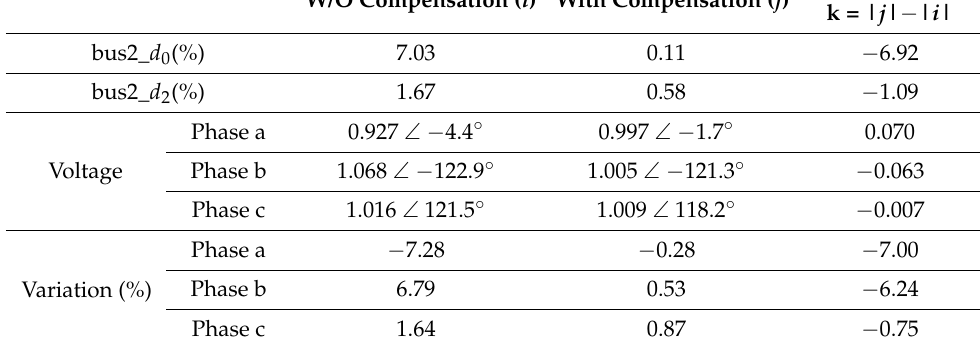
Table 5. Voltage unbalanced factor and voltage variation in Case B.